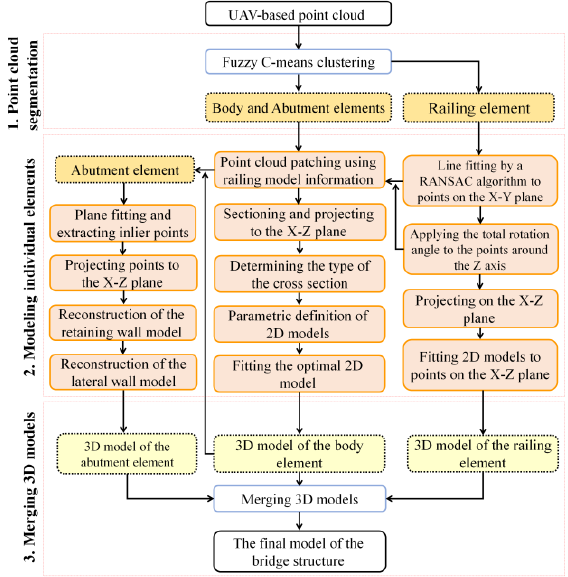
Figure 1. The flowchart of the proposed method.